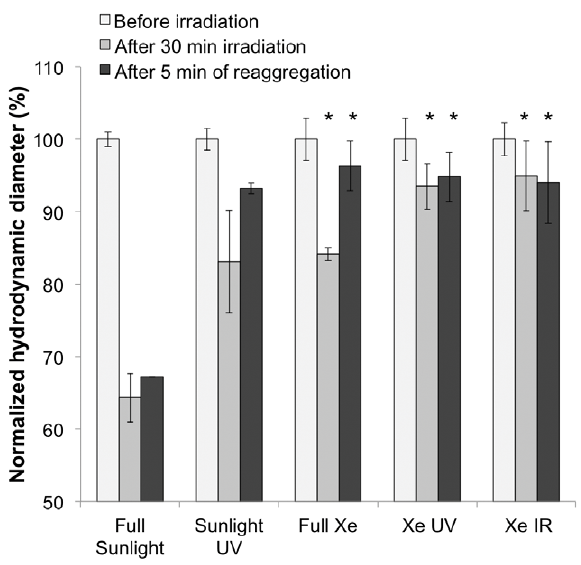
Figure 2. Induced disaggregation after irradiation of 100 mg L 2 1 TiO 2 NP suspension with full spectrum sunlight and Xe arc lamp, as well as UVA or IR filtered light. In general the exposures with the greatest intensities induced the largest disaggre- gation. Irradiation was conducted for 30 min. for all experiments. In general a degree of reaggregation was observed after a few minutes. Error bars reflect a standard deviation. Stars indicate statistical significance with a p-value #